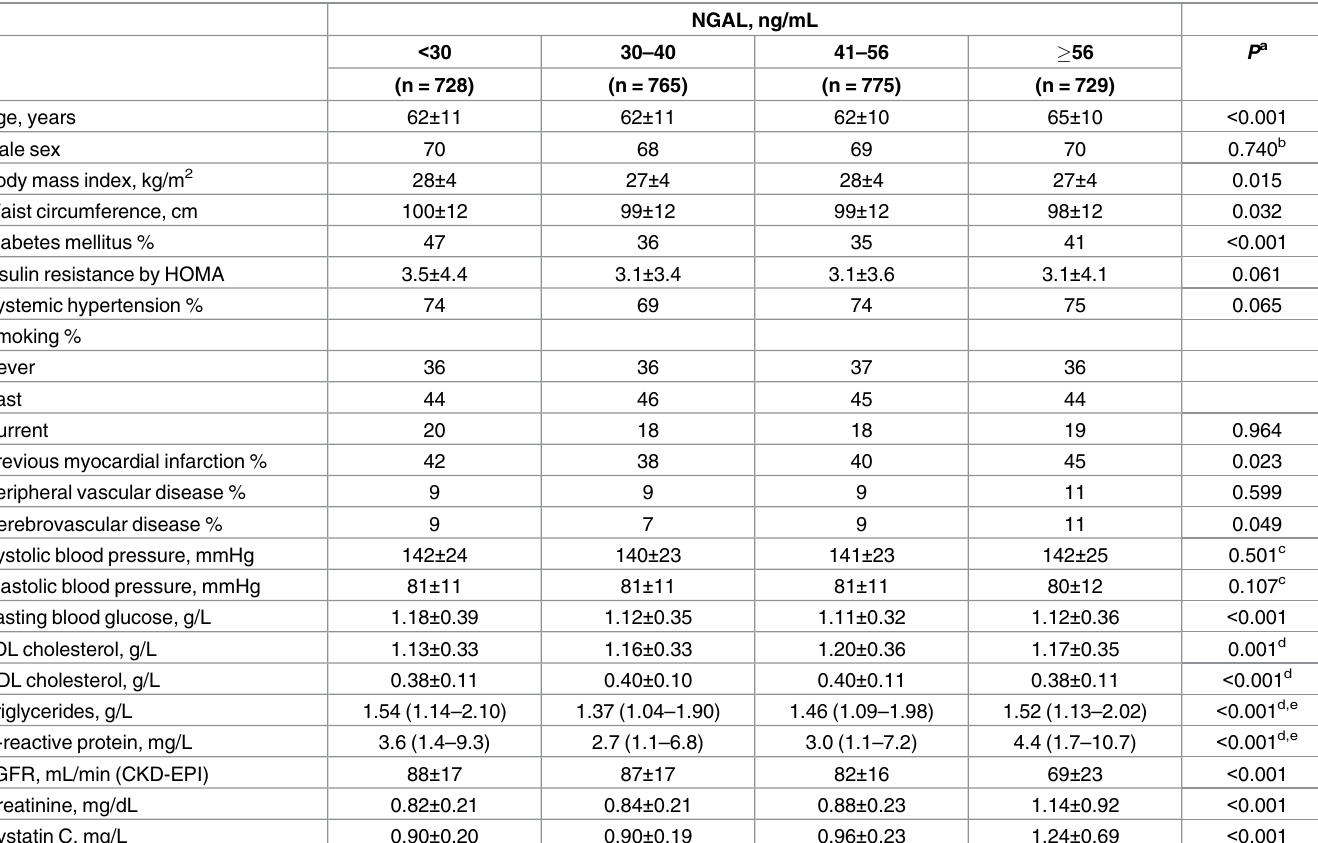
Table 2. Clinical and biochemical characteristics of study participants at